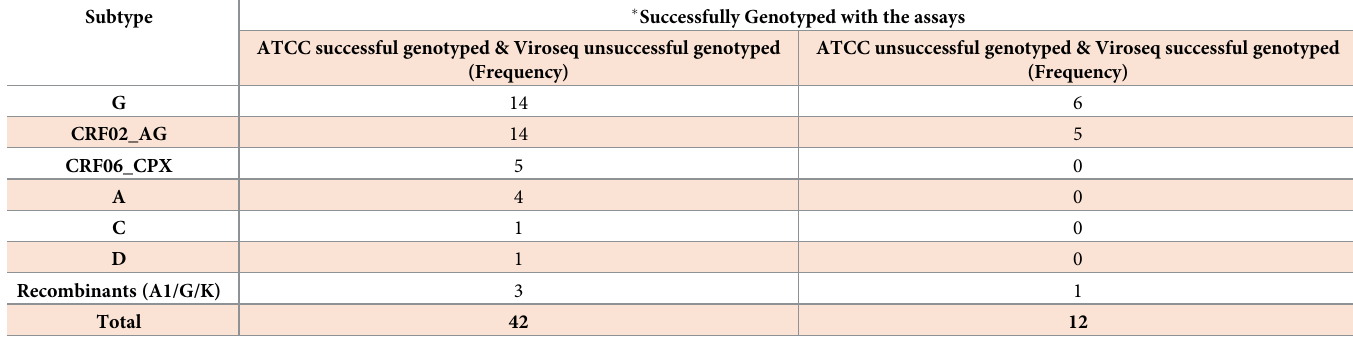
(cid:3) Subtypes were determined on ATCC or Viroseq sequences with successful